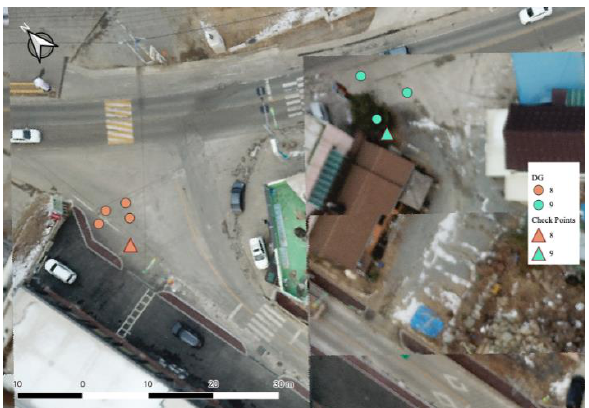
Figure 8. Seamlines between individual orthoimages (DG)